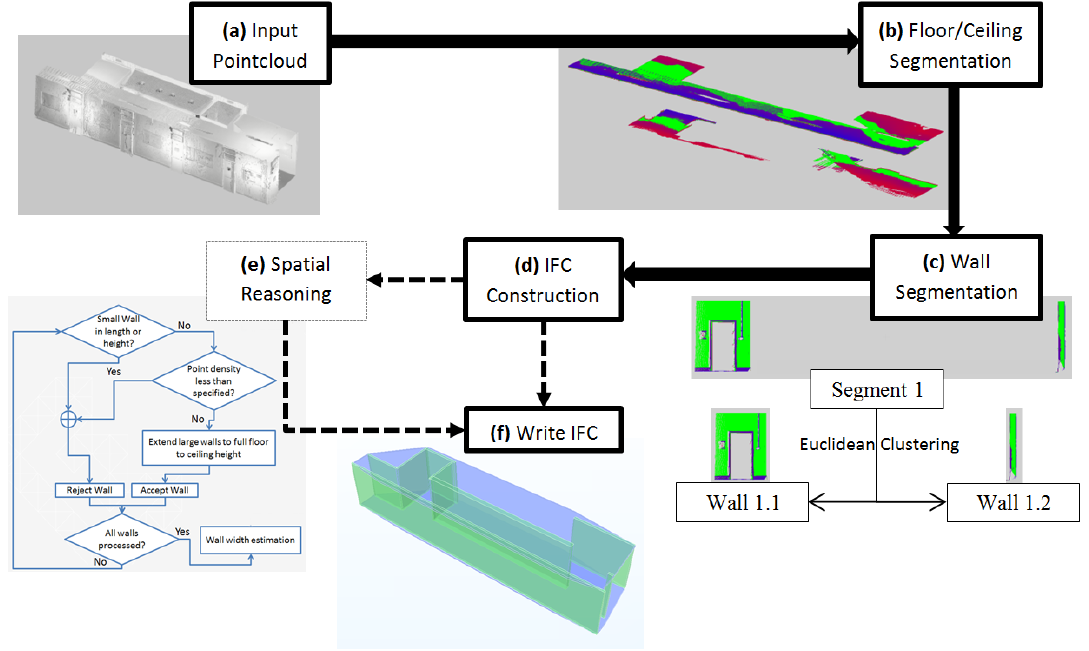
Figure 1. Flowchart of Point Cloud to IFC algorithm steps. ( a ) Load Point Cloud; ( b ) Segment the Floor and Ceiling Planes; ( c ) Segment the Walls and split them with Euclidean Clustering; ( d ) Build IFC Geometry from Point Cloud segments; ( e )